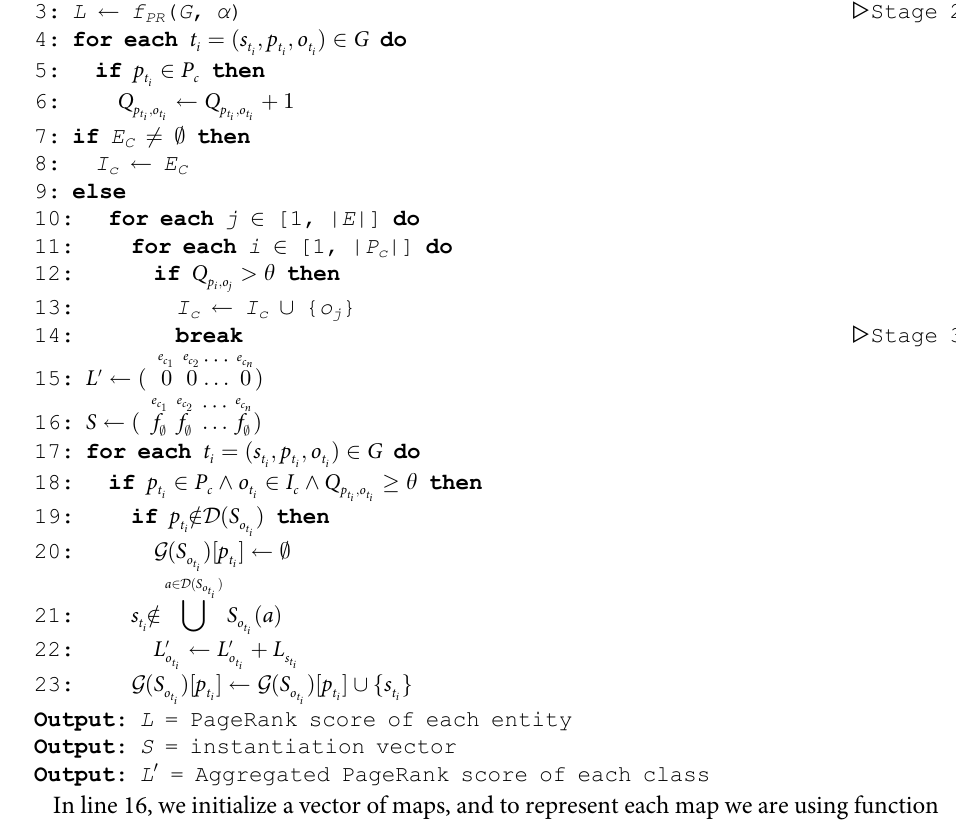
Algorithm 1 receives as input a target graph G , a set P